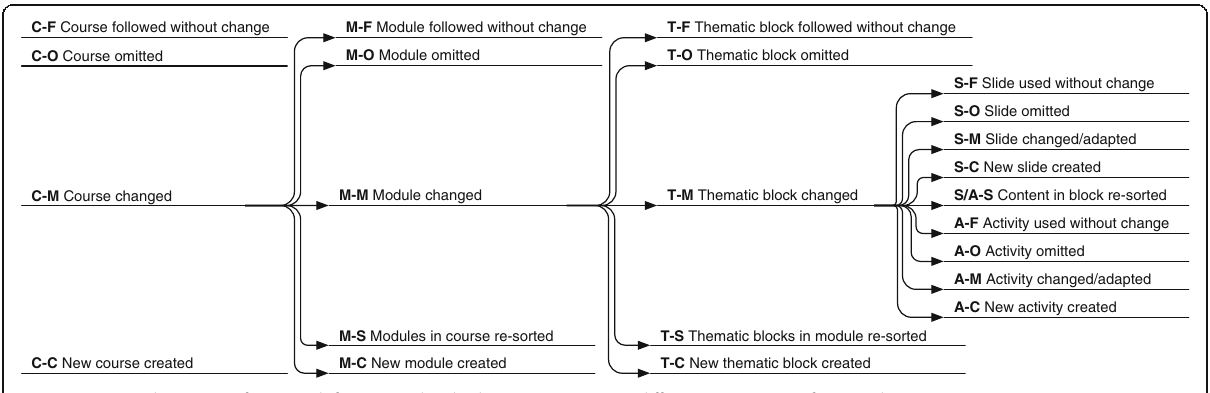
Fig. 2 FOMSC scheme as a framework for materialized adaptation actions in different grain sizes of